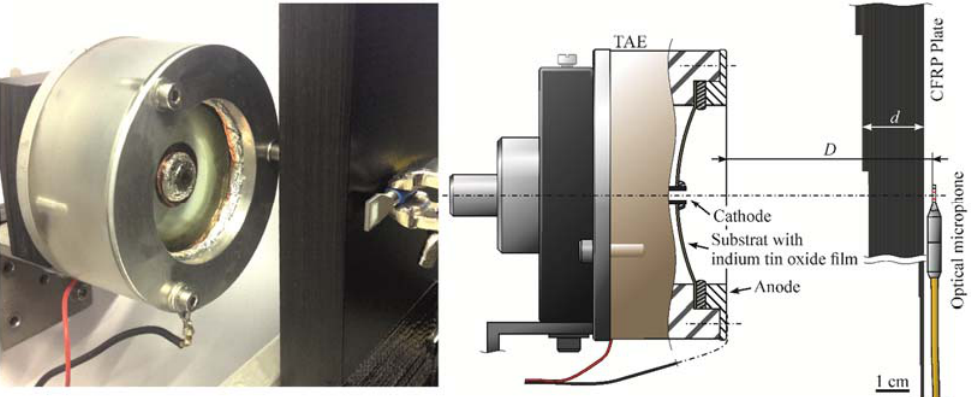
Figure 1. Image and schematic of the air ‐ coupled ultrasound transmission setup. Sending and re ‐ ceiving transducers were positioned on both sides of the CFRP step wedge. The emitter consists of a thin indium tin oxide film in between two electric poles. The receiver was an optical microphone. The distance between transmitter and receiver D and the thickness of the plate could be determined experimentally.